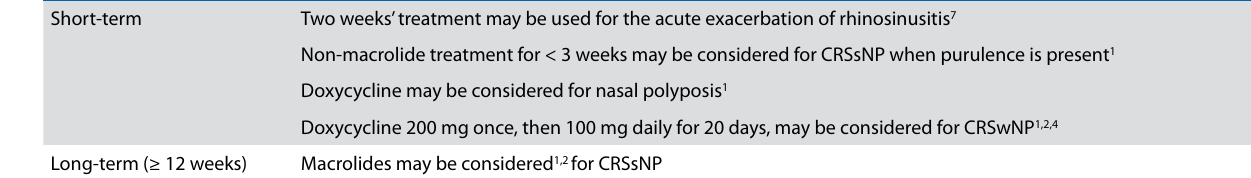
Table VII: The duration of treatment of oral antibiotics